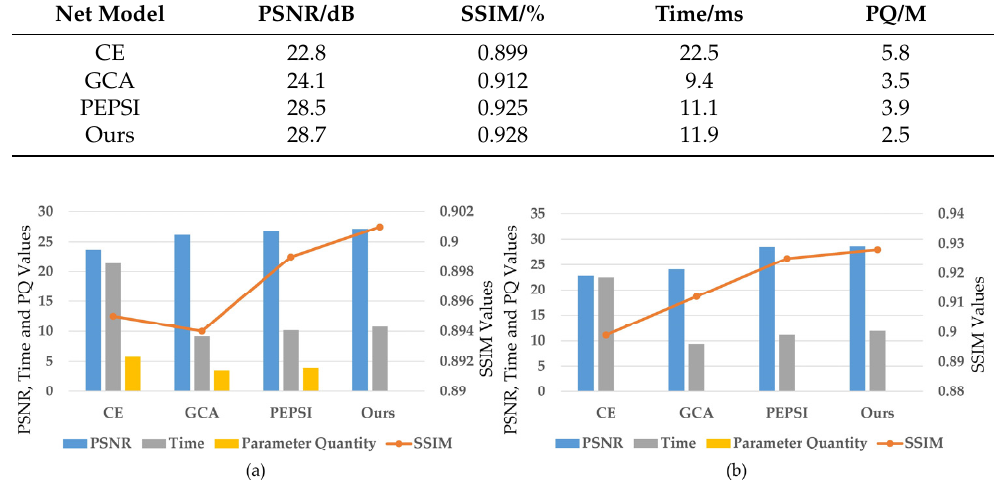
Table 5. Performance of di ff erent inpainting methods for free-form masked images.